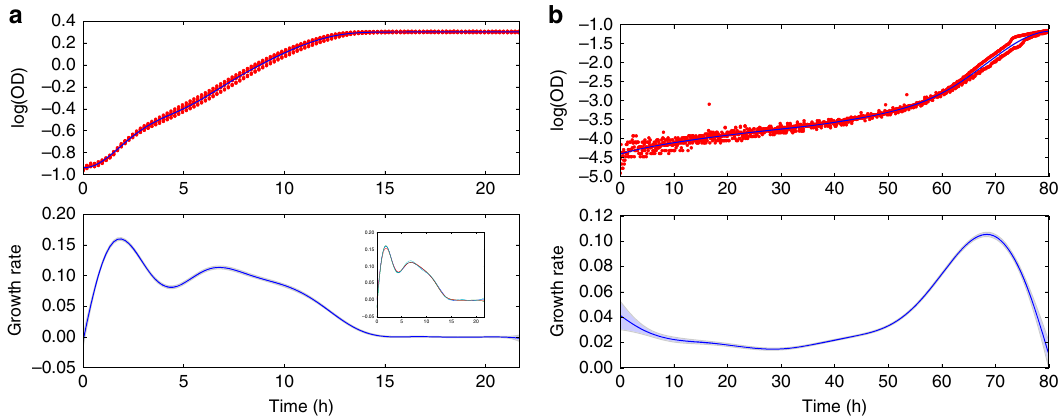
Figure 4 | Microbial growth rates can be inferred as a function of time. ( a ) A growth curve of S. cerevisiae in a mixture of 0.4% glucose and 1% galactose showing a diauxic shift (7 replicates, each with n ¼ 115). The best-fit (mean) latent function is shown in dark blue and the inferred growth rate is shown below. All error bars (light blue) are s.d. The inset shows, as an example, four sample estimates of the growth rate as a function of time (samples of the first derivative of the latent function—the corresponding samples of the latent function itself are not shown). ( b ) Growth of E. coli in hyperosmotic conditions with an unusually long lag and short growth period (two replicates, each with n ¼ 646) and the inferred growth rate. The magnitude of the measurement noise is here allowed to vary with time and empirically estimated across the replicates (Methods). Error bars (light blue) are s.d.